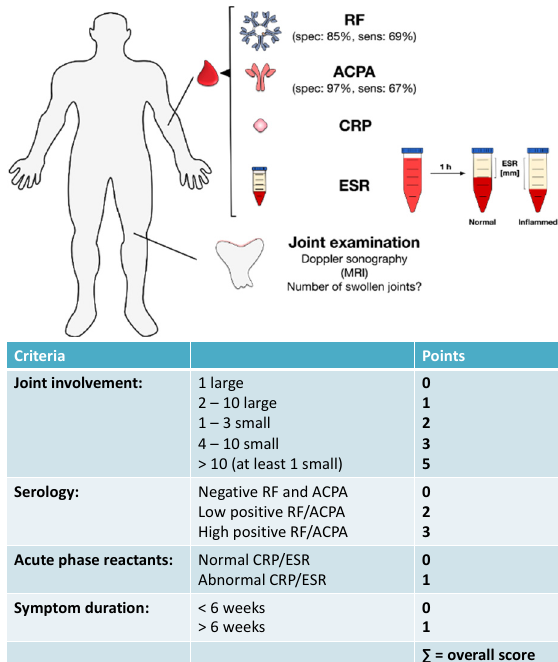
Figure 3. Clinical parameters frequently used in the diagnosis of RA and their quantification using the 2010 ACR-EULAR (American College of Rheumatology-European League against Rheumatism) classification criteria. Clinical diagnosis (left) of RA relies on joint examination (mainly via sonography, but also by magnetic resonance imaging (MRI)), and the serological determination of RA-specific autoantibodies (Rehmatoid factor (RF) and ACPAs) and detection of elevated levels of C-reactive protein (CRP) and an increased erythrocyte sedimentation rate (ESR). The 2010 ACR-EULAR RA classification criteria (right). Scoring parameters are number and size of the involved joints, the presence and concentration of RA-specific ACPAs and RF autoantibodies, presence of abnormal levels of CRP and increased ESR, and overall duration of disease symptoms. According to the 2010 ACR-EULAR RA classification criteria a RA diagnosis is made if the overall score is greater than six and other causes for synovitis (see above) can be excluded.